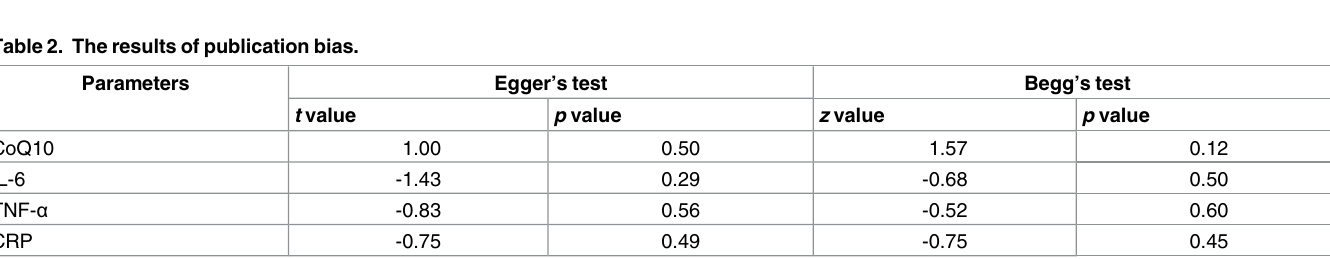
Table 2. The results of publication